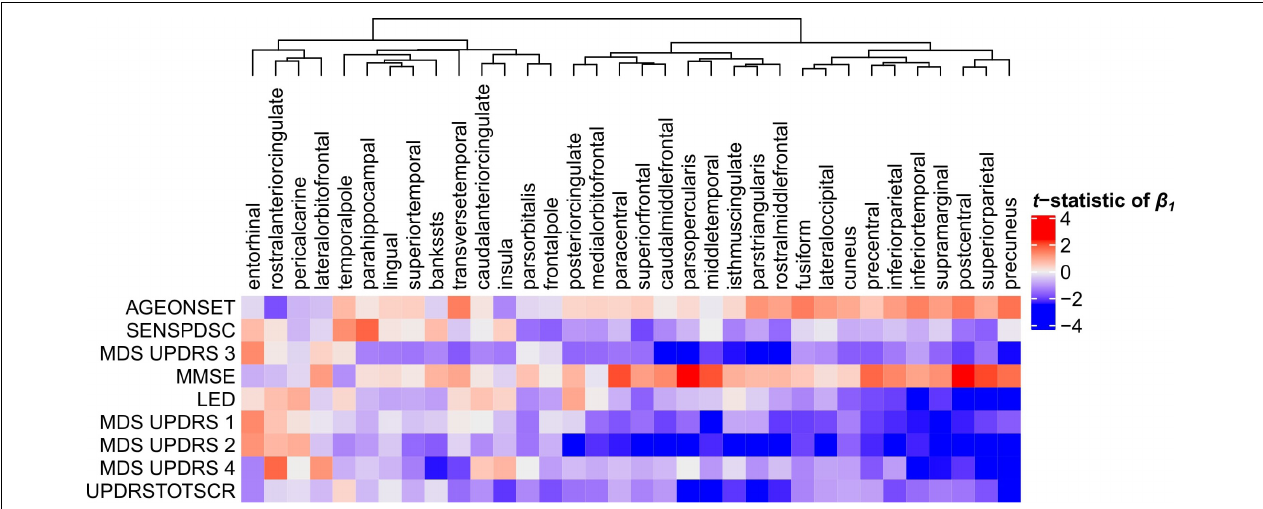
FIGURE 4 | Relationship between clinical scores and CT across PD patients. Linear regression was used to predict clinical scores from CT across at most 123 PD patients ( Supplementary Figure 1 ). Separate models were used for each clinical feature (row) and cortical region (column) to obtain regression coefficients, see Eq. 1. The heatmap shows the two-sided t -statistics of the regression coefficient when tested for H 0 : β 1 = 0. Regions (columns) are clustered based on complete linkage of the Euclidean distance of the t -statistics of β 1